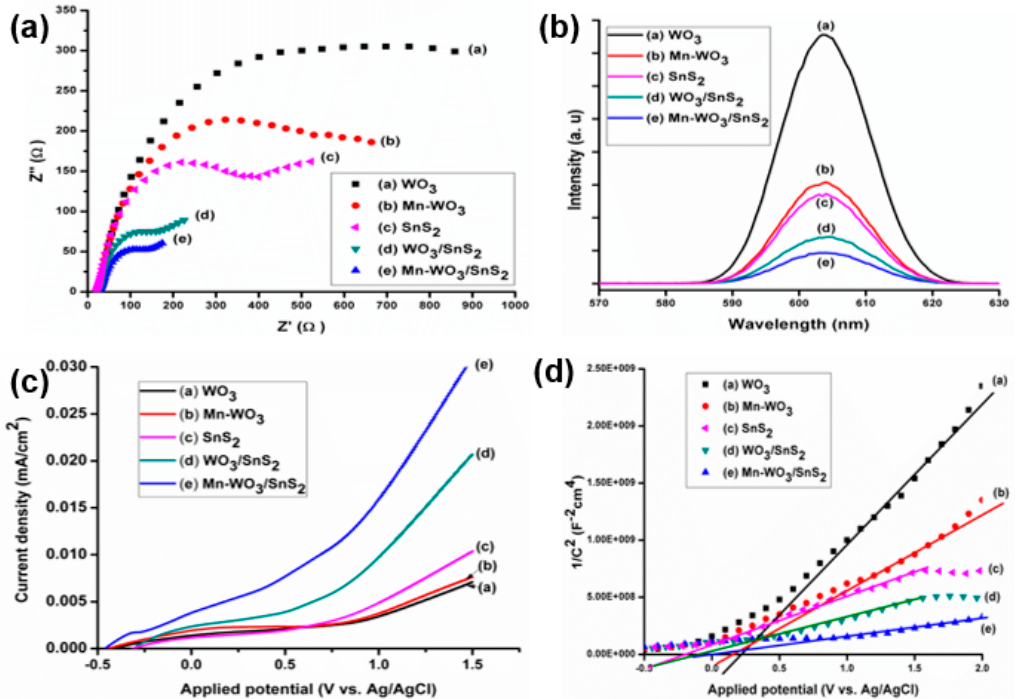
Figure 6. ( a ) Electrochemical impedance spectra (Nyquist plot), ( b ) photoluminescence spectra, ( c ) linear sweep voltammetry, and ( d ) Mott–Schottky plot of (a) WO 3 , (b) Mn-WO 3 , (c) SnS 2 , (d) WO 3 / SnS 2 and (e) Mn-WO 3 / SnS 2